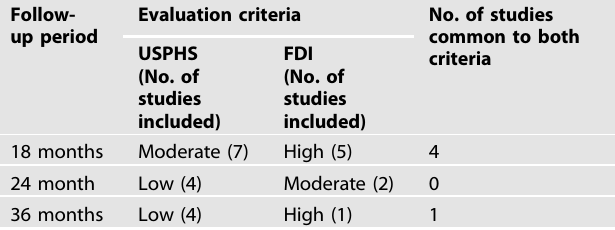
Table 4. GRADEpro assessment of certainty of evidence at 18 month follow-up using FDI and USPHS criteria.